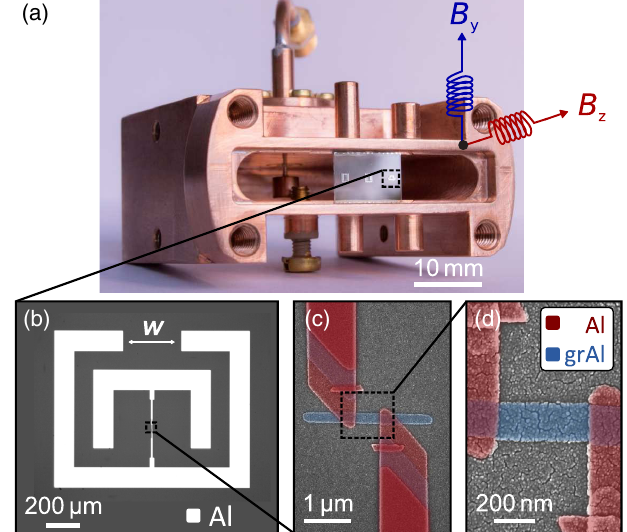
FIG. 1. Sample design. (a) Photograph of a copper waveguide sample holder equipped with a microwave port similar to Ref. [34], and, optionally, with a 2D vector magnet (see the Appendix A). The vector magnet is schematically represented by the blue and red coils, oriented along the y and z directions. The sample is positioned in the center of the waveguide and couples to its electric field along the y direction. (b) Optical image of the qubit sample, consisting of two Al pads forming a capacitor ≈ 137 fF, connected by a grAl inductor L ≈ 2 . 85 nH. We C s k adjust the coupling of the sample to the waveguide by changing the gap w (see Appendix B). (c),(d) Scanning electron microscope (SEM) image of the grAl inductor (false colored in blue) with 10 × 200 × 500 nm 3 and the Al leads (false volume V grAl ¼ colored in red). The grainy surface structure is due to the antistatic Au layer used for imaging. The circuit is obtained in a single lithography step by performing a three-angle shadow evaporation. The Al layer shunts the grAl film in all areas, except for the volume V in the center, which constitutes the source of nonlinearity for grAl 0 . 45 nH, and the the qubit [30]. The geometric inductance is L s ¼ contacts contribute to the L with 0.13 nH (see Appendix k